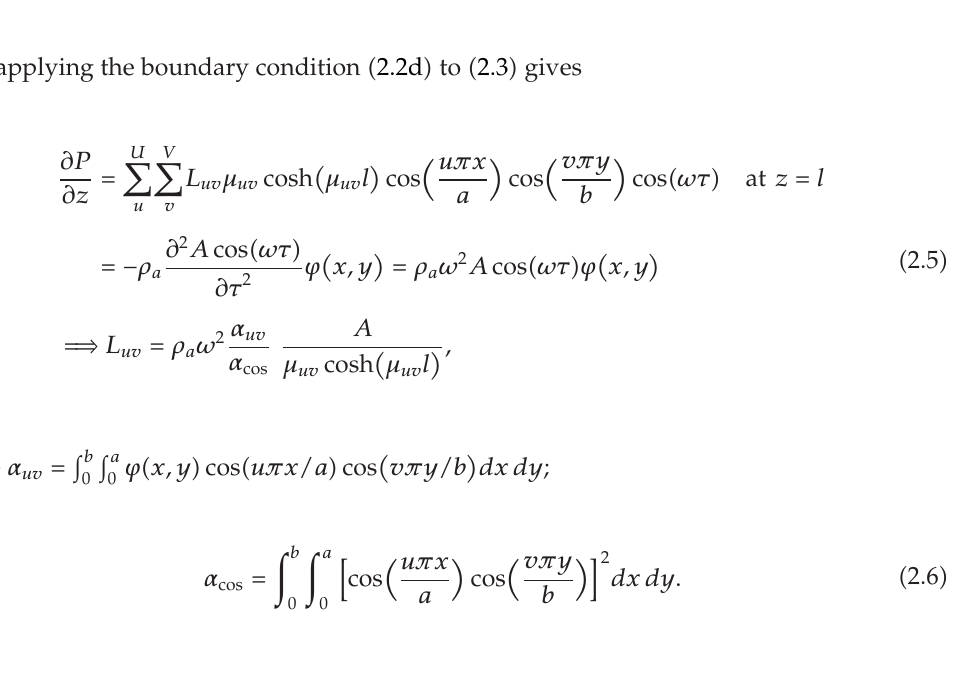
Applying the boundary condition (cid:3) 2.2c (cid:6) to (cid:3) 2.3 (cid:6) gives